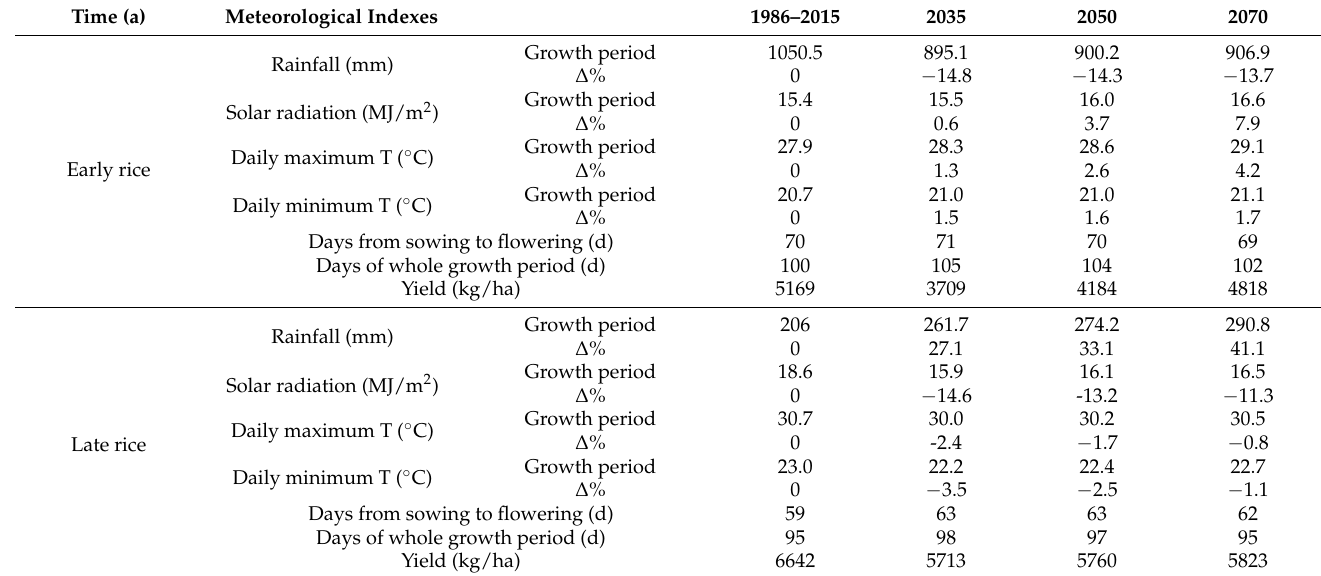
Table 5. Changes in precipitation, solar radiation, temperature, phenological period, and yield in double-harvest rice growing period in